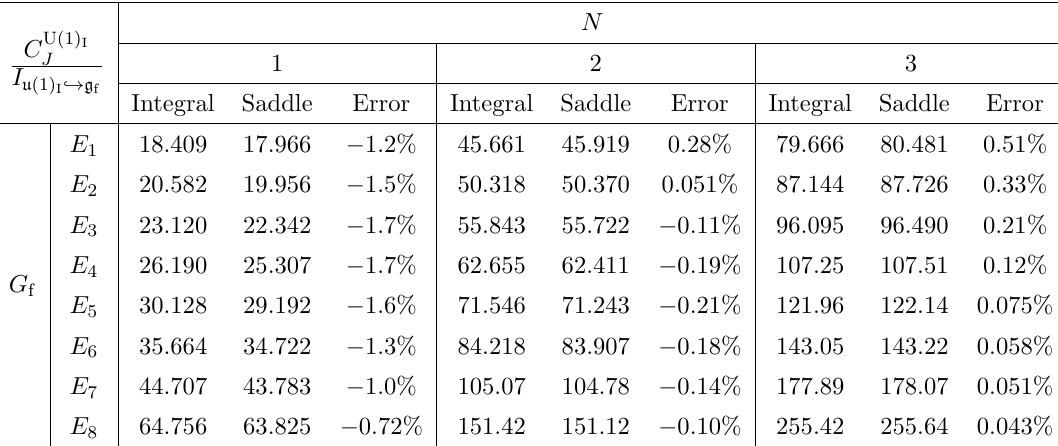
Table 6 . The perturbative values of the (cid:13)avor central charge C G f Seiberg theories, obtained using the instanton particle mass, computed by numerical integration and by the saddle point